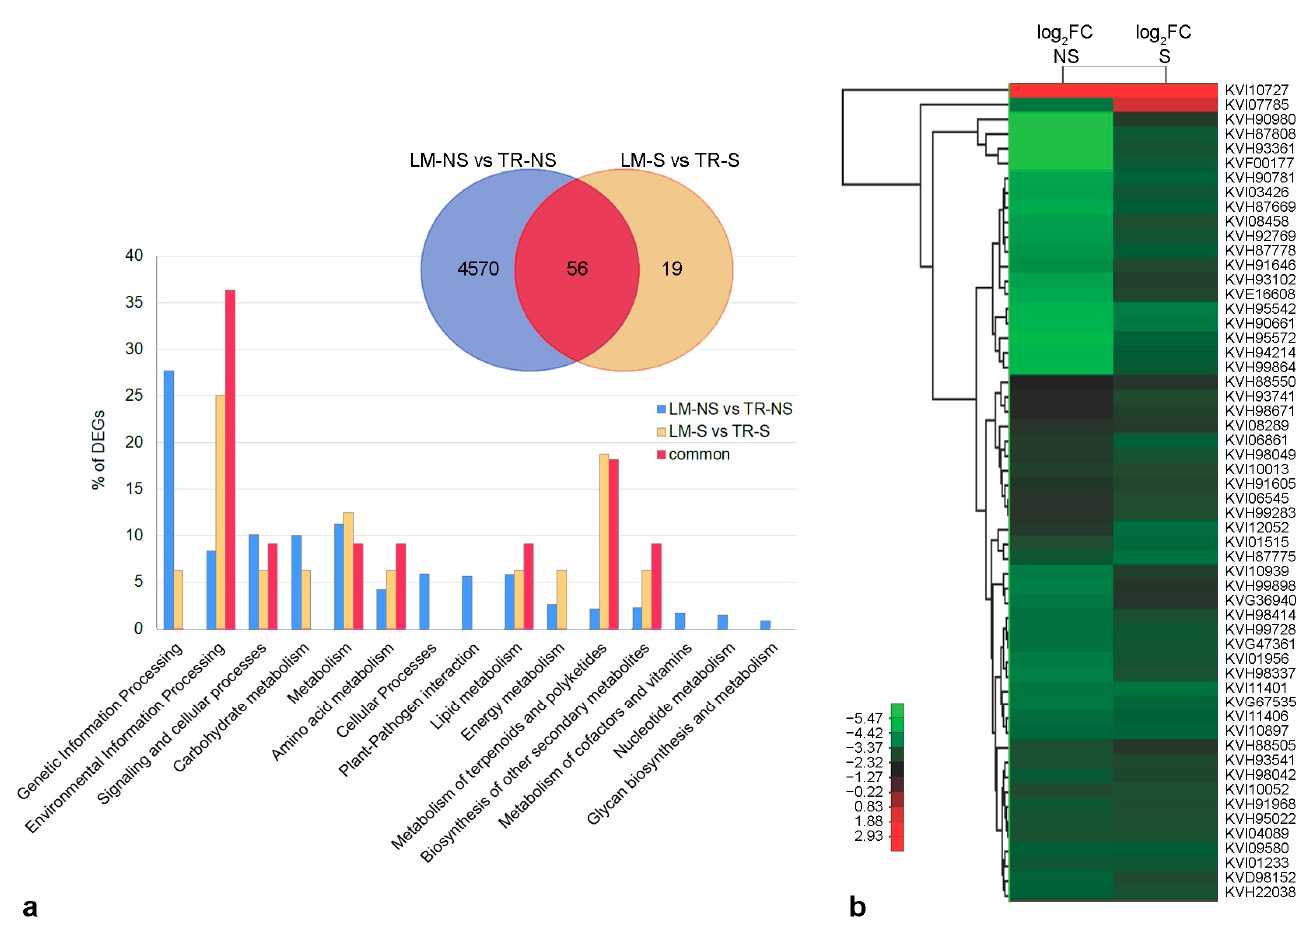
Figure 5. Functional classification and hierarchical clustering analysis of differentially expressed genes (DEGs) between Locale di Mola (LM) and Troianella (TR). ( a ) The Venn diagram shows the number of DEGs (FDR ≤ 0.05; |log 2 FC| ≥ 1) in LM compared to TR samples. The histogram shows the functional distribution of annotated DEGs exclusively modulated in LM compared to TR in non-sanitized (NS) condition (4570 DEGs, blue bars), in sanitized (S) condition (19 DEGs, yellow bars), and in common (56 DEGs, red bars) between NS and S samples. ( b ) The heatmap shows a hierarchical clustering analysis of expression levels (log 2 FC) of annotated DEGs in common between NS and S samples of the LM and TR ecotypes.